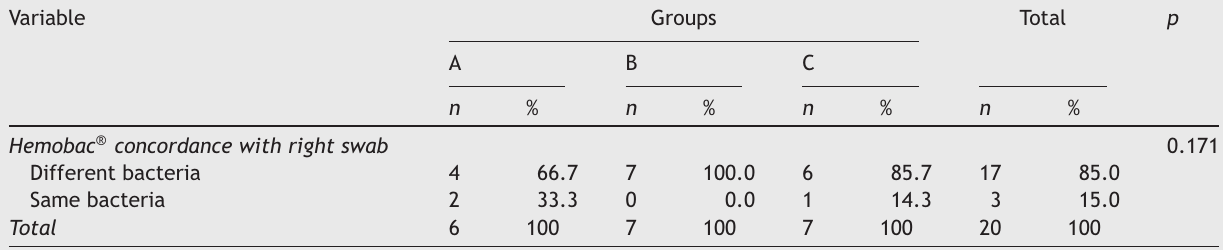
Description of the agreement of the nasal pack bacteria and microbiology in the induced side according to the groups and statistical test